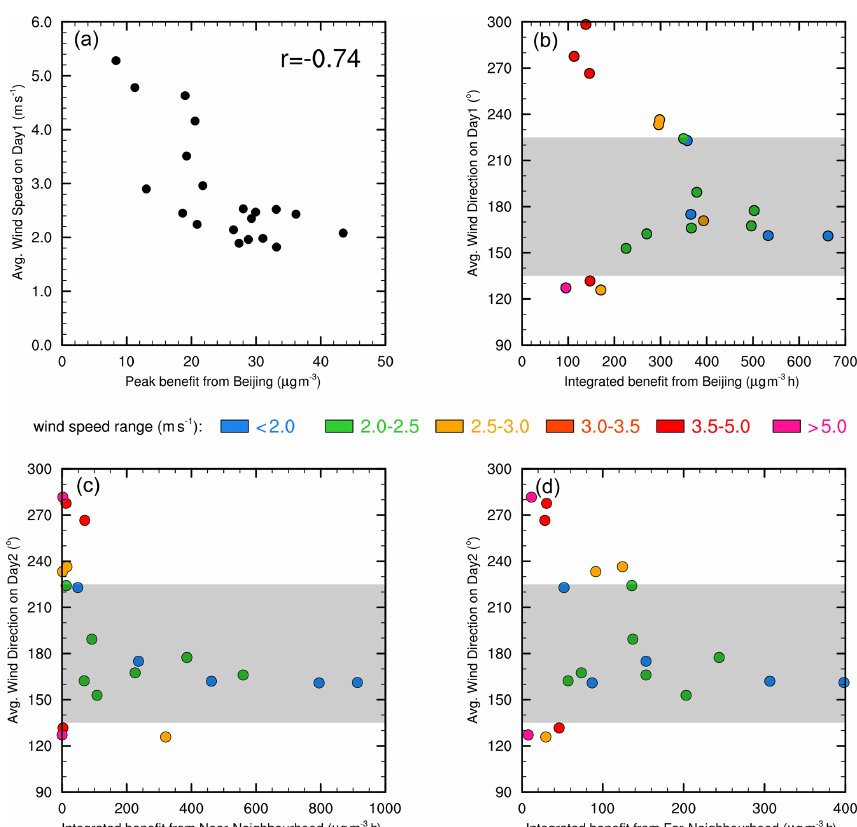
Figure 5. Effect of meteorology on peak and integrated contributions from the three regions of control. (a) Peak contribution from Beijing sources vs. average wind speed on day 1, (b) integrated contribution from Beijing vs. average wind direction on day 1, and integrated contribution from (c) near-neighbourhood and (d) far-neighbourhood sources vs. average wind direction on day 2. The shaded area highlights southerly